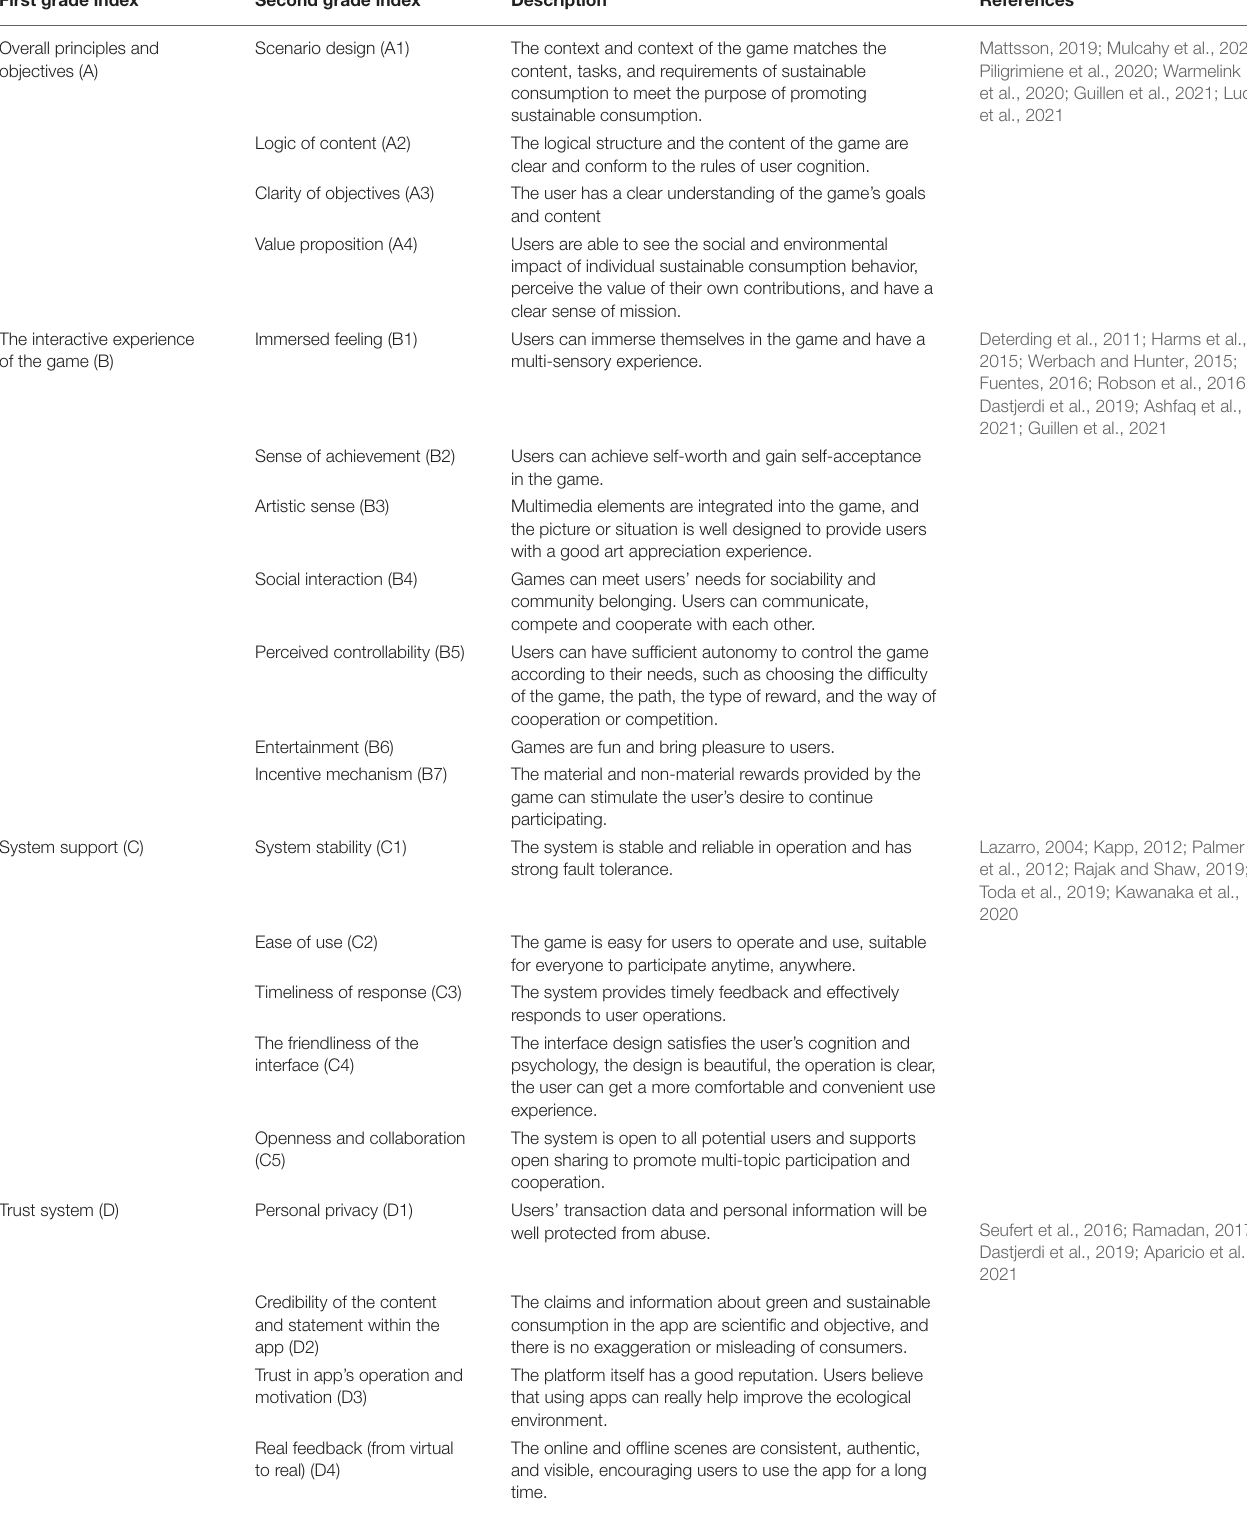
TABLE 3 | Evaluation index system of gamification design for sustainable consumption